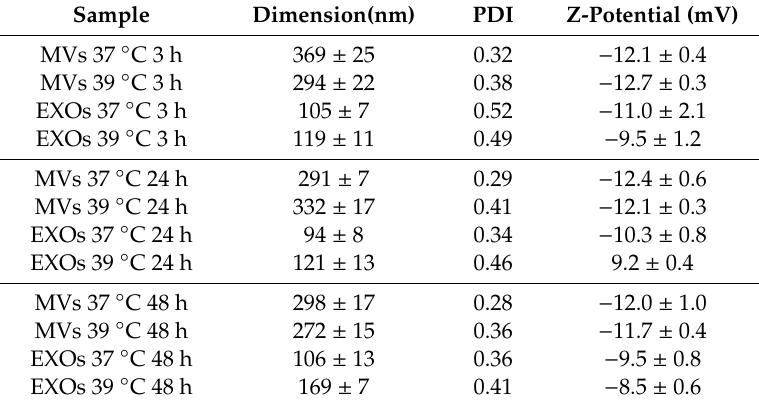
Table 1. Particle size, polydispersity index (PDI), and zeta-potential (Z-potential) of MVs (microvesicles) and EXOs (exosomes) derived from dendritic cells